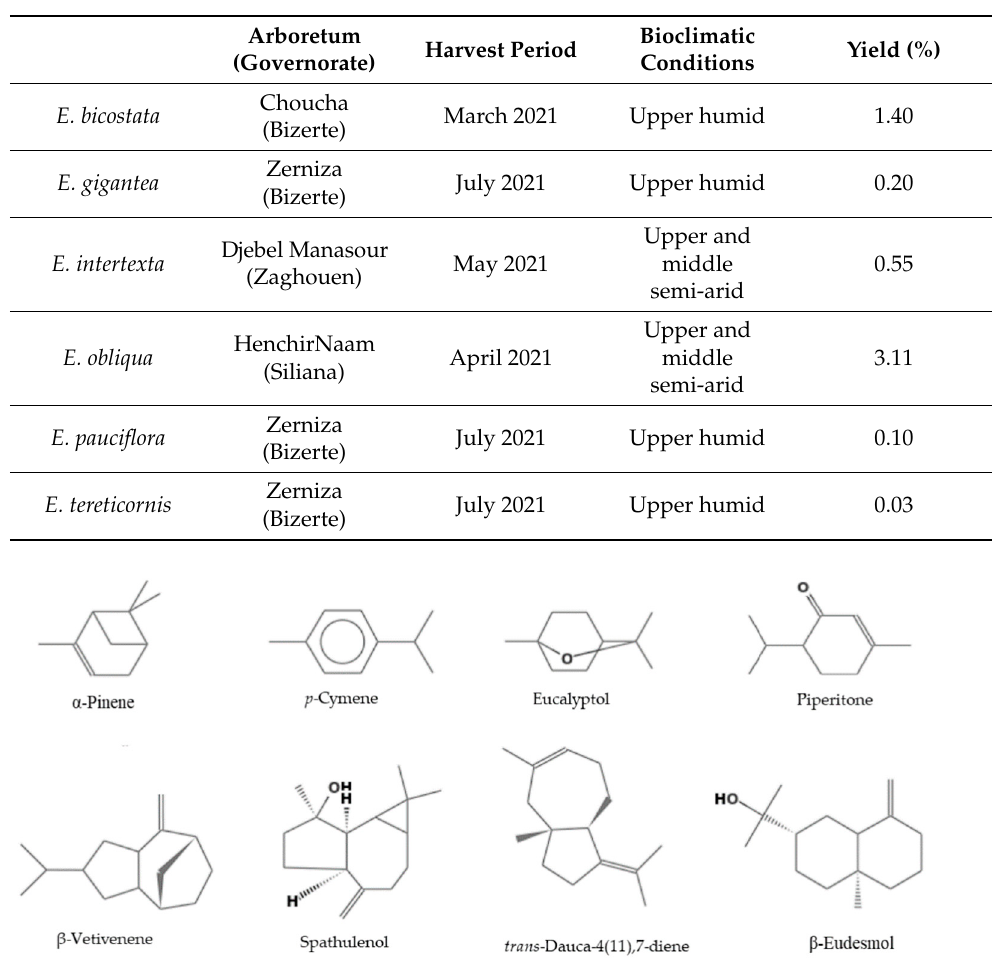
Figure 2. The main constituents of the EOs.